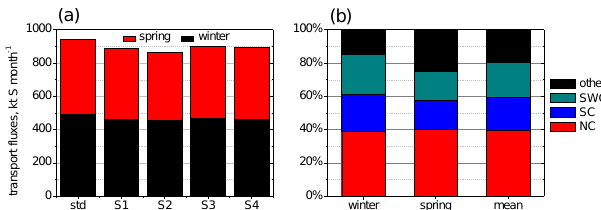
Figure 8. (a) Sulfur (SO 2 + sulfate) flux on the 123 ◦ E, 22– 42 ◦ N tropospheric plane from China to the western Pacific, and (b) percentage contribution of NC, SC, SWC and other regions (the rest of Chinese regions as well as global influence) to sulfur Figure 7. Annual mean sulfate concentration and population- (SO 2 + sulfate) transport fluxes from China to the western weighted sulfate concentration over China (sulfate and population data of Taiwan Province are not available). Table 2. Change in population-weighted sulfate concentrations, in µgm − 3 . Difference with the standard simulation Standard simulation S1 S2 S3 S4